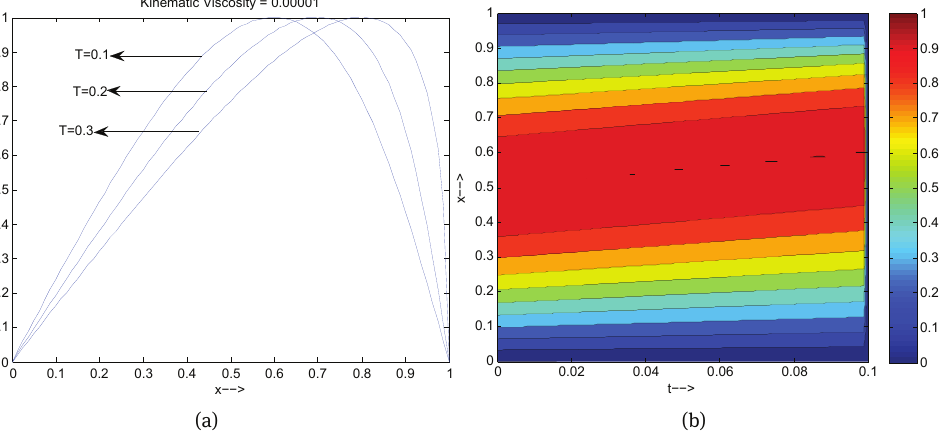
Fig. 14: Physical behavior of numerical solutions for Example 1 in 2D and contour form for ν = 0.00001 at different times with Δx = 0.0125 and Δt = 0.001